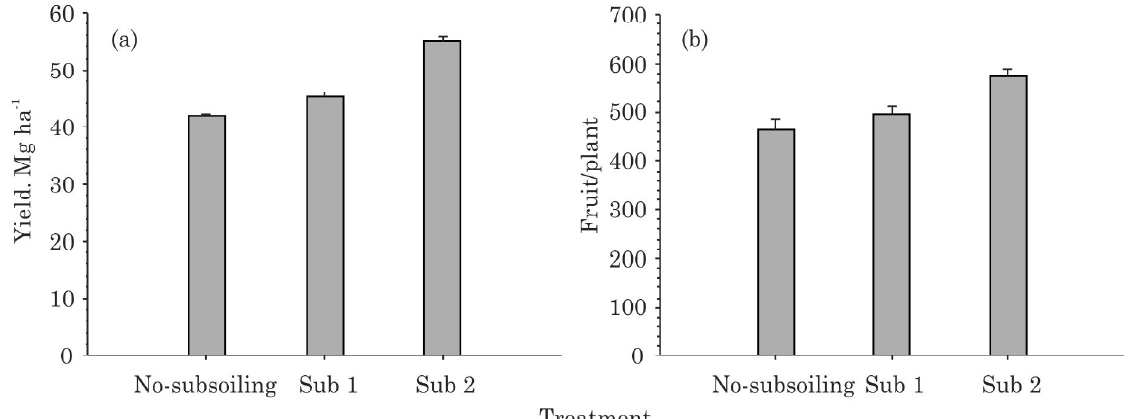
Figure 5. Fruit yield (a) and number of fruits per plant (b) in a citrus orchard subjected to the treatments: no-subsoiling, subsoiled on one side of the plant lines ( Sub. 1 ), and subsoiled on both sides of the plant lines ( Sub. 2 ). The vertical bars indicate standard